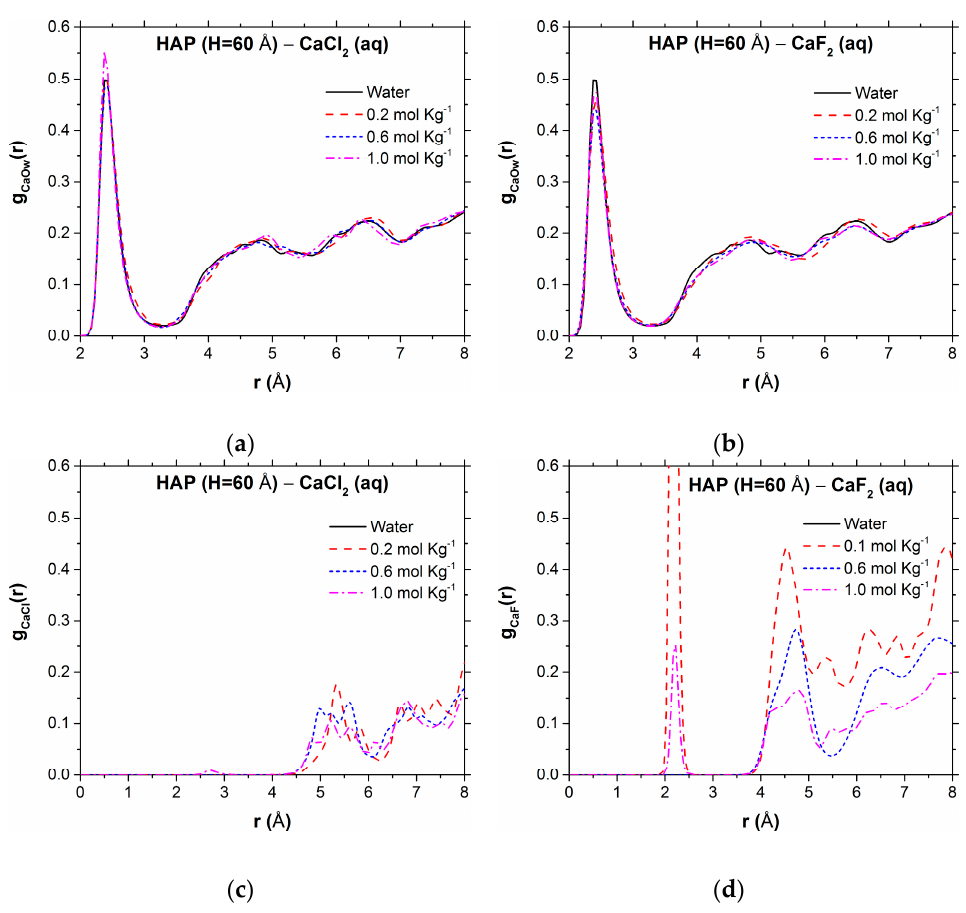
Figure 6. Radial distribution functions between calcium and water oxygen (g CaO (r)) in the ( a ) HAP nanopore (H = 60 Å)–CaCl 2 solutions and ( b ) HAP nanopore (H = 60 Å)–CaF 2 solutions. ( c ) Ca–Cl radial distribution functions (g CaCl (r)) in the HAP nanopore (H = 60 Å)–CaCl 2 solutions. ( d ) Ca–F radial distribution functions (g CaF (r)) in the HAP nanopore (H = 60 Å)–CaF 2 solutions.